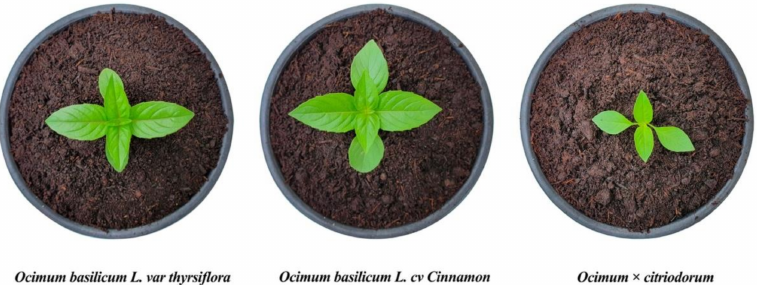
Figure 1. Illustrative pictures of the different types of basil at transplant. From left to right: Ocimum basilicum L. var thyrsiflora (Anise), Ocimum basilicum L. cv Cinnamon, and Ocimum × citriodorum